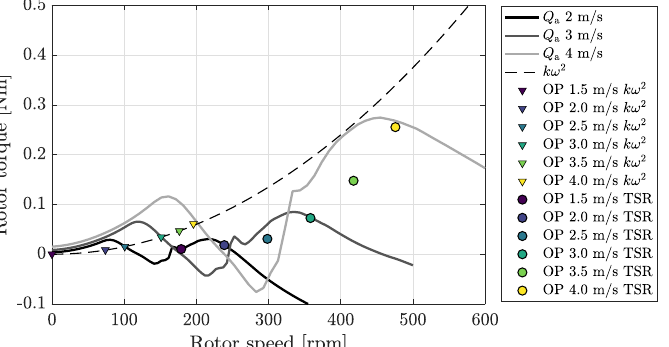
Figure 6. Steady-state operating points (OP) with k ω 2 and TSR tracking control algorithms ( Q a is the aerodynamic torque at rotor).